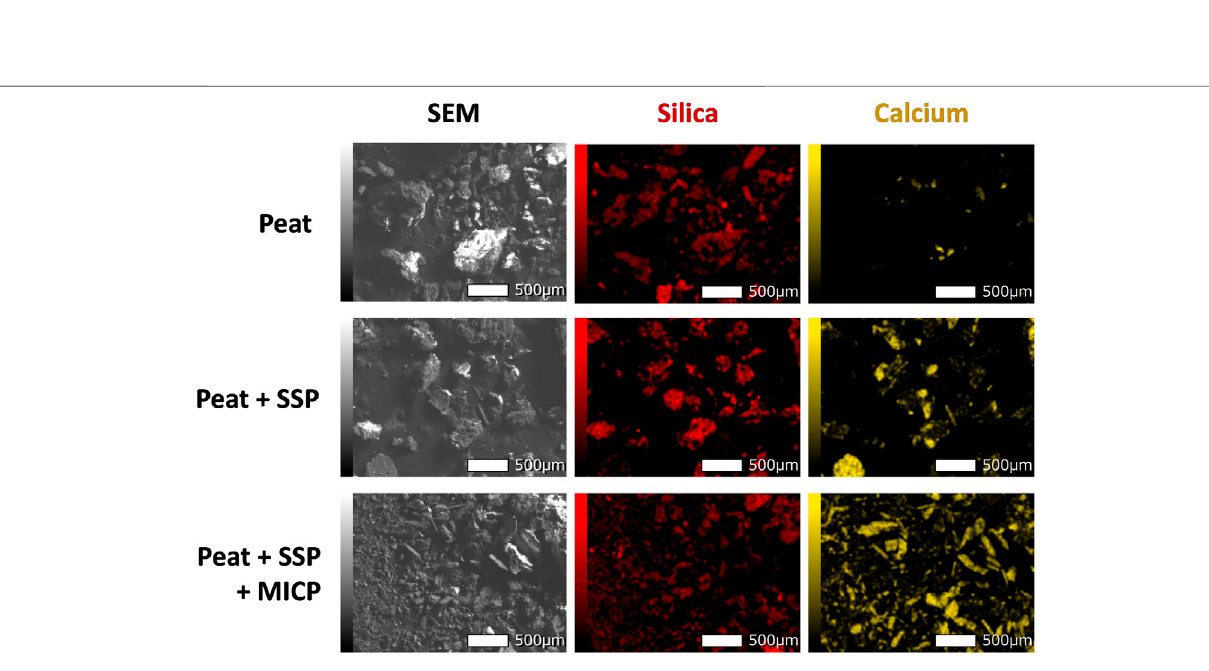
Frontiers in Environmental Science |